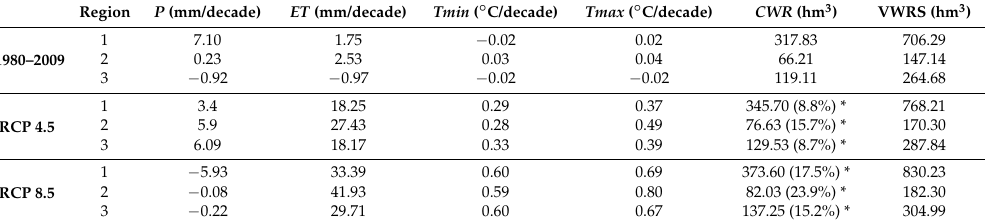
Table 2. Current and projected changes per ID in climatic variables and water